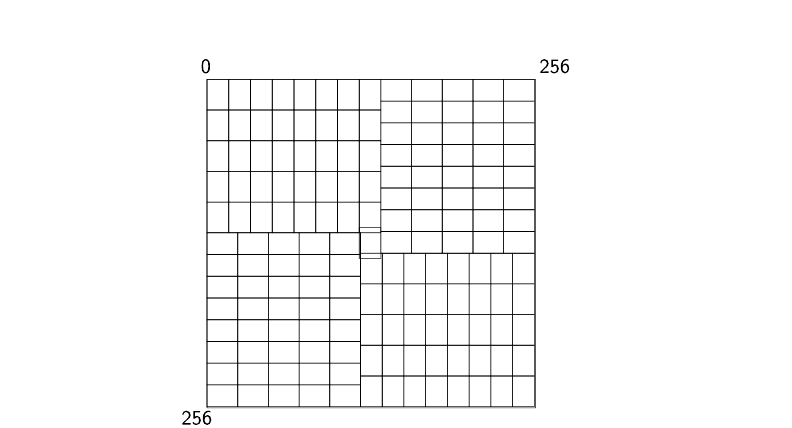
Those last registers are believed to be rebalanced by the FPGA synthesis tool, since this is not the bottleneck of the maximum period of the circuit.